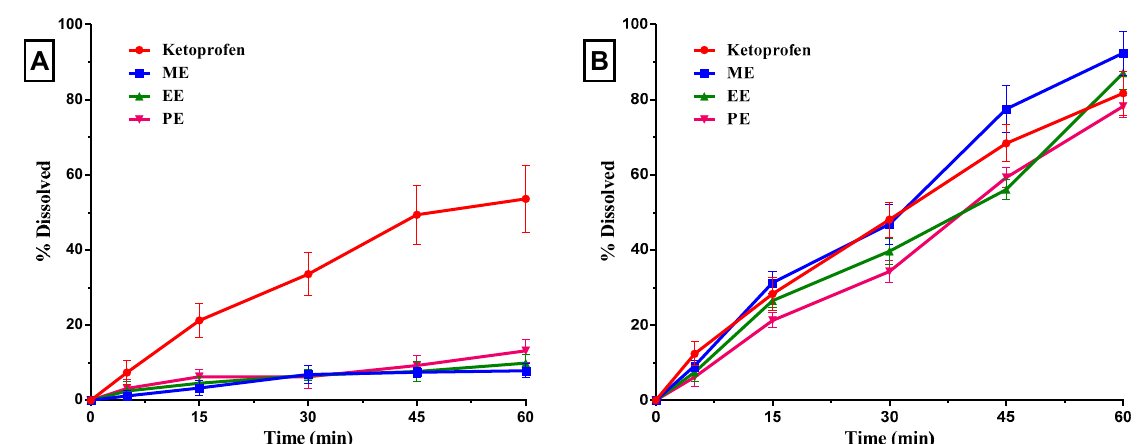
Figure 1. In vitro dissolution profiling of ester prodrugs of ketoprofen showing % drug dissolved in HCl buffer pH 1.2 ( A ) and phosphate buffer pH 6.8 ( B ). Data was expressed as mean ± SEM, where n = 6. ME: Methyl 2-(3-benzoyl phenyl) propanoate, EE: Ethyl 2-(3-benzoyl phenyl) propanoate, PE: Propyl 2-(3-benzoyl phenyl) propanoate.